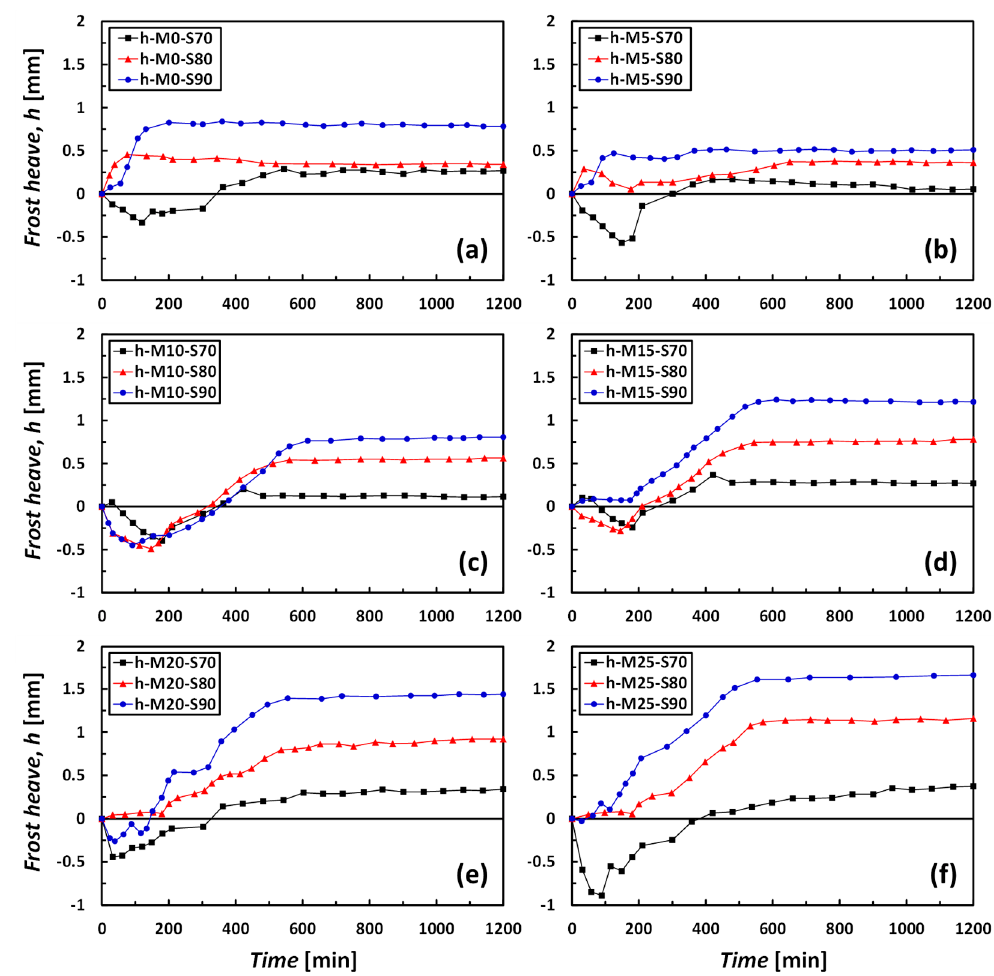
Figure 5. Results of frost heaving tests. ( a ) M = 0%, ( b ) 5%, ( c ) 10%, ( d ) 15%, ( e ) 20%, and ( f )